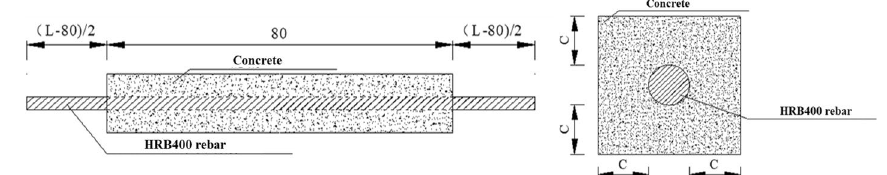
Fig. 2 Schematic diagram of the dimensions of the reinforced concrete structure specimen